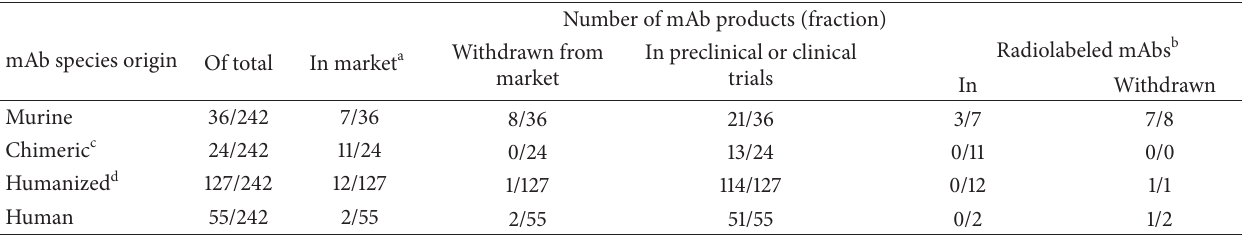
Table 6: Status of monoclonal antibodies in 2009